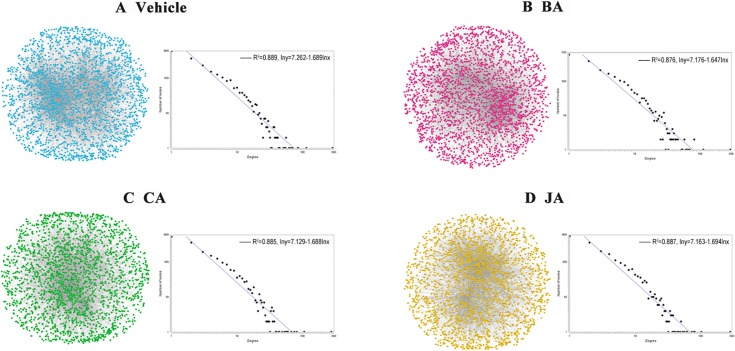
Global networks of vehicle, BA, CA, and JA groups.The degree distribution of the four networks can be approximated by a power law distribution, which appears as a straight line on a logarithmic plot.